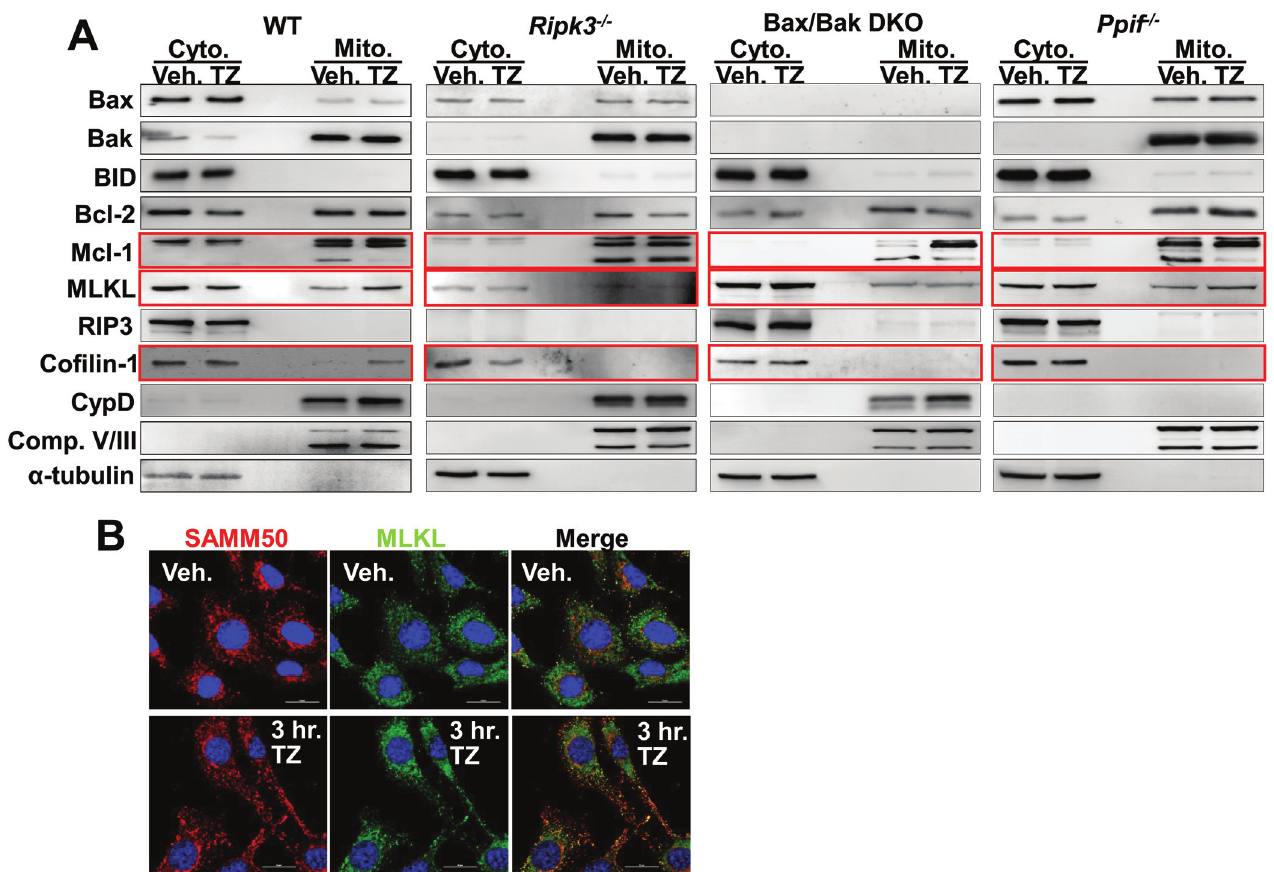
Fig 4. Upstream necroptotic regulators signal to the mitochondrion through Mcl-1. A, Western blots for Bax, Bak, BID, Bcl-2, Mcl-1, MLKL, RIP3, cofilin-1, CypD, Complex V and III (mitochondrial loading control), and α tubulin (cytoplasmic loading control) from cytoplasmic and mitochondrial extracts from WT, Ripk3 null, Bax/Bak1 DKO, and Ppif null MEFs treated with TNF α and zVAD-FMK (TZ) or vehicle (Veh.) for 6 hours. B, Immunocytochemistry for MLKL (green) and mitochondrial protein SAMM50 (red) on WT MEFs treated with TNF α and zVAD-FMK (TZ) or vehicle (Veh.) for 3 hours. Nuclei are stained with Dapi